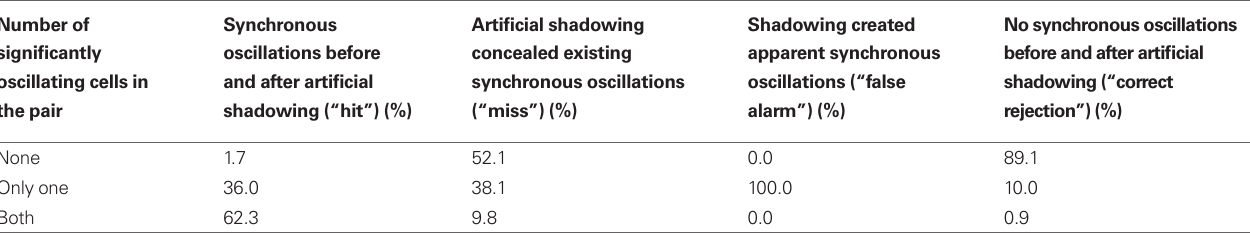
Relationships between firing properties of each of the single neurons in a given pair, and the outcome of the shadowing effect. The left column gives the number of cells within a pair that were defined as oscillatory. Each of the next columns addresses one of the four possibilities of detection of synchronous oscillations given the shadowing effect (signal detection theory). That is, synchronous oscillations were detected before and after shadowing (“hit”); synchronous oscillations were concealed by the shadowing (“miss”); shadowing created apparent synchronous oscillations (“false alarm”); or there were no synchronous oscillations both before and after synchronous oscillations (“correct rejection”). We present here the probability of having none, one, or both oscillatory cells within the pair, given each one of the four possibilities (so that each column is summed to 100%). We can see that all “false alarms” occurred when only one of the cells in the pair was oscillatory. On the other hand, about half of the “misses” occurred when none of the cells in the pair were significantly